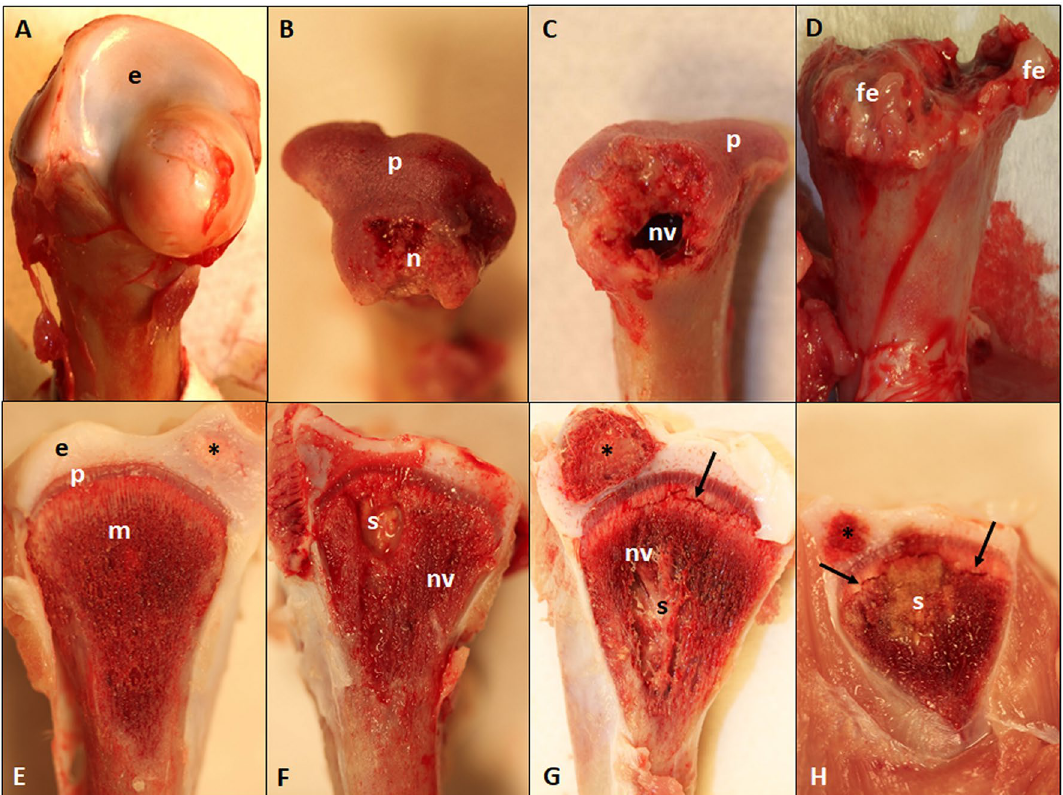
Figure 1. Stages of proximal femoral degeneration ( A – D ) and proximal tibial degeneration ( E – H ) leading progressively to bacterial chondronecrosis with osteomyelitis: ( A ) Normal proximal femur with white cap of epiphyseal cartilage ( e ); ( B ) Femoral head separation (FHS: epiphyseolysis) with the epiphysis remaining in the socket when the femur was disarticulated, revealing the underlying surface of the growth plate or physis (p) and an early region of necrosis (n); ( C ) Fracturing of the growth plate (p) revealing a necrotic void (nv) within the metaphysis; ( D ) Terminal femoral head necrosis in which the femoral epiphysis, physis and most of the metaphysis remained attached to the acetabulum when the diaphysis weakened by widely dispersed necrosis was fractured during disarticulation, revealing copious fibrinonecrotic exudate (fe); ( E ) Normal proximal tibia showing the epiphysis (e) with a secondary center of ossification (*) and the physis/growth plate (p) fully supported by struts of trabecular bone in the metaphyseal zone (m); ( F – H ) Bacterial infiltration and sequestrae (s), necrotic voids (nv) and microfractures below the growth plate (arrows) provide macroscopic evidence of bone damage associated with